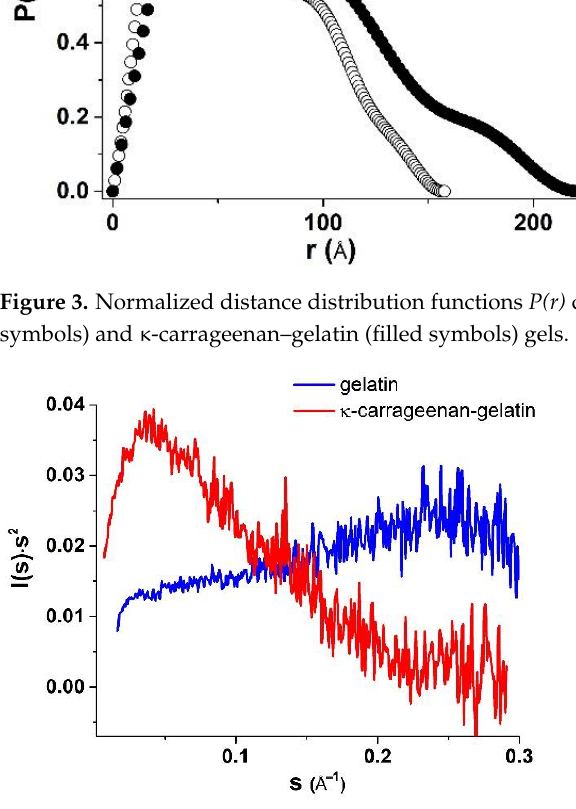
Figure 4. Kratky plots for gelatin and κ -carrageenan–gelatin Figure 4. K ratky plots for gelatin and κ -carrageenan – gelatin gels.